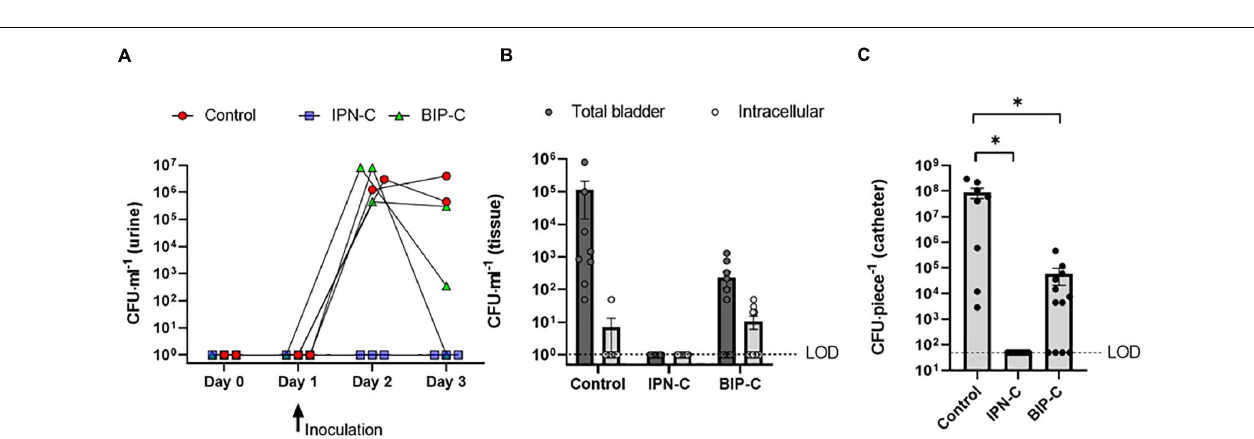
FIGURE 6 | Bacterial burden of inoculated pigs. All controls (red circle) and all pigs with a BIP-C (green triangle) developed significant E. coli bacteriuria ( > 10 5 CFU ml − 1 ) 24 h after inoculation (day 2) (A) . On day 3, one pig in the BIP-C group had cleared the infection (sterile urine) while another had only minor bacteriuria (3.5 × 10 2 CFU ml − 1 ). E. coli remained undetectable throughout the experiment in urine samples from pigs with an interpenetrating polymer network interpenetrating polymer network (IPN)-C (blue square). Bladder-wall-associated bacteria were present in control pigs and two of three pigs in the BIP-C group but were undetectable in the IPN-C group (B) . Intracellular bacteria were few and, in most cases, undetectable for all groups. No E. coli were detectable on the IPN-C catheters (C) . BIP-C catheters revealed significantly less E. coli biofilm compared to control, and one catheter was completely devoid of E. coli colonization (C) . Bars represents means ± standard error of the mean. (B,C) Represents data from four tissue/catheter samples from each animal. CFU numbers in C represents adherent bacteria from 10 mm catheter pieces. * P = 0.0032, one-way ANOVA with Tukey’s multiple comparisons test. CFU, colony forming units; LOD, limit of detection was